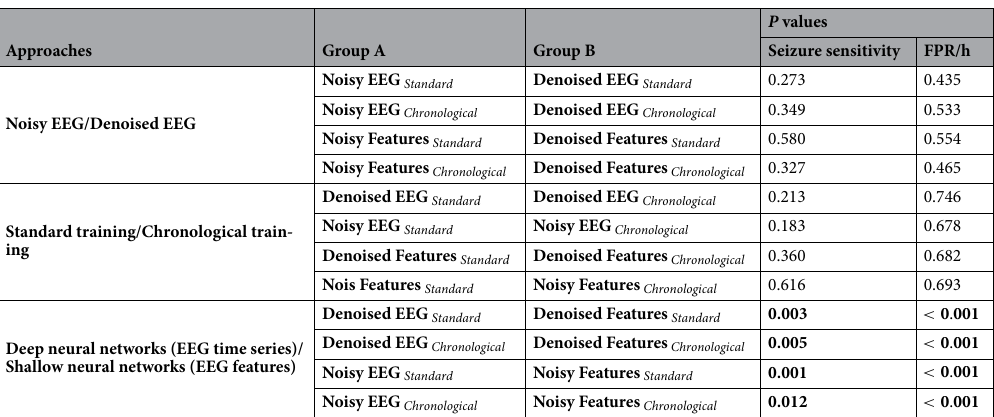
Table 3. P values obtained for the statistical comparisons performed between all developed approaches using seizure sensitivity and FPR/h values. The comparisons were performed using one-tail Mann-Whitney, considering an alpha of 0.05. For seizure sensitivity, the p-values correspond to the probability of the distribution of group B being greater than the distribution of group A. For FPR/h, the p-values correspond to the probability of the distribution of group B being lower than the distribution of group A, except for the comparison between deep neural networks (EEG time series) and shallow neural networks (EEG features). In this particular case, the FPR/h values obtained for group B were higher, so the p-values correspond to the probability of group B being greater than group A. Significant values are in